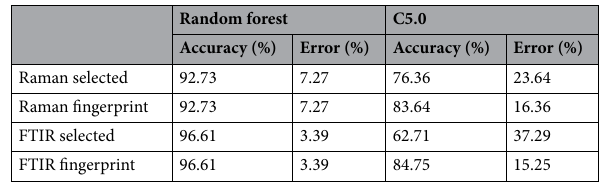
Table 3. Percentage accuracy with error value of selected and for fingerprint region (800–1800 cm −1 ) for obtained Raman and FTIR spectra.